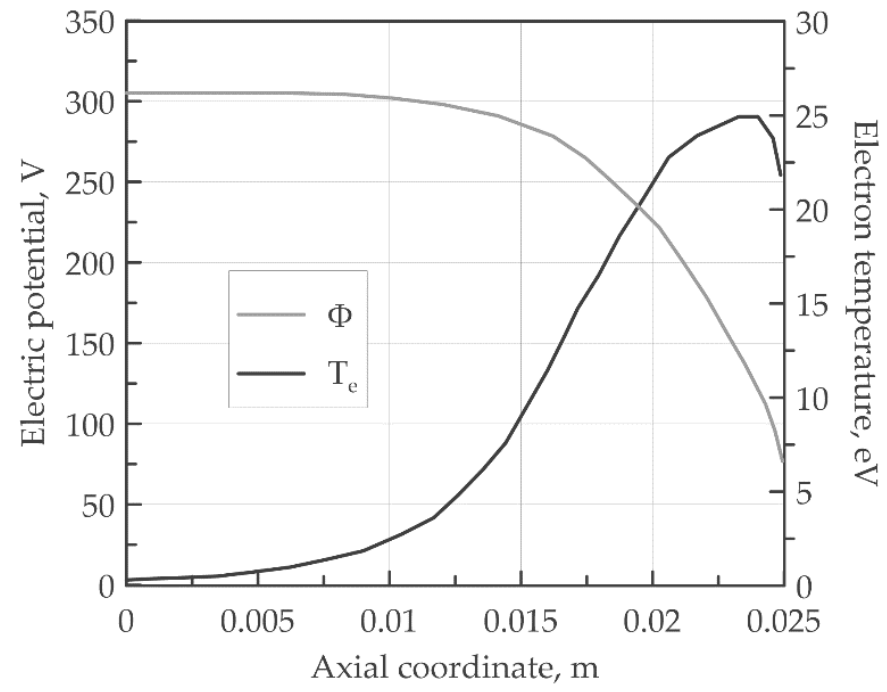
Figure 5. A representation of the electric field and the electron temperature. Figure 6 shows the neutrals and plasma density contours with the velocity vectors. A highly neutral density region is placed in the proximity of the anode where the neutrals are injected, which decreases along the axial coordinate due to the ionization process of the neutrals. A recirculation zone is detected in the proximity of the upper-left and bottom-left corners. On the other hand, the ion density peak takes place in correspondence with the region in which the product ζ ( T e ) · n n reaches its maximum. After the peak, the velocity increases exponentially, due to the electric potential drop near the channel exit, and consequently, the density drops down in order to conserve the total particles’ number. To compare the results obtained in the present work with that shown in the reference work, the one-dimensional distribution of neutral and ion densities is shown in Figure 7a. The plots are obtained averaging the distribution along the radial coordinate. A good agreement between the numerical results is displayed. Finally, Figure 7b shows the total, the neutral, and the ionized mass flow rate computed along the axial coordinate and, as stated above, the total mass flow rate is fully